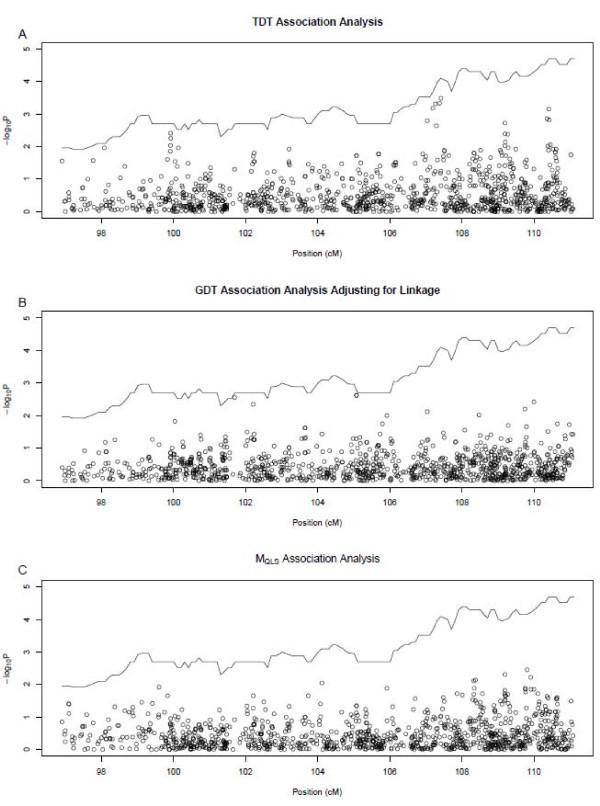
P values of association from two association tests: A. TDT, B. GDT, C. MQLS. P values in -log10 scale are represented by circles. The solid line indicates p values of non-parametric LOD scores with LD modeled at r2 > 0.2.